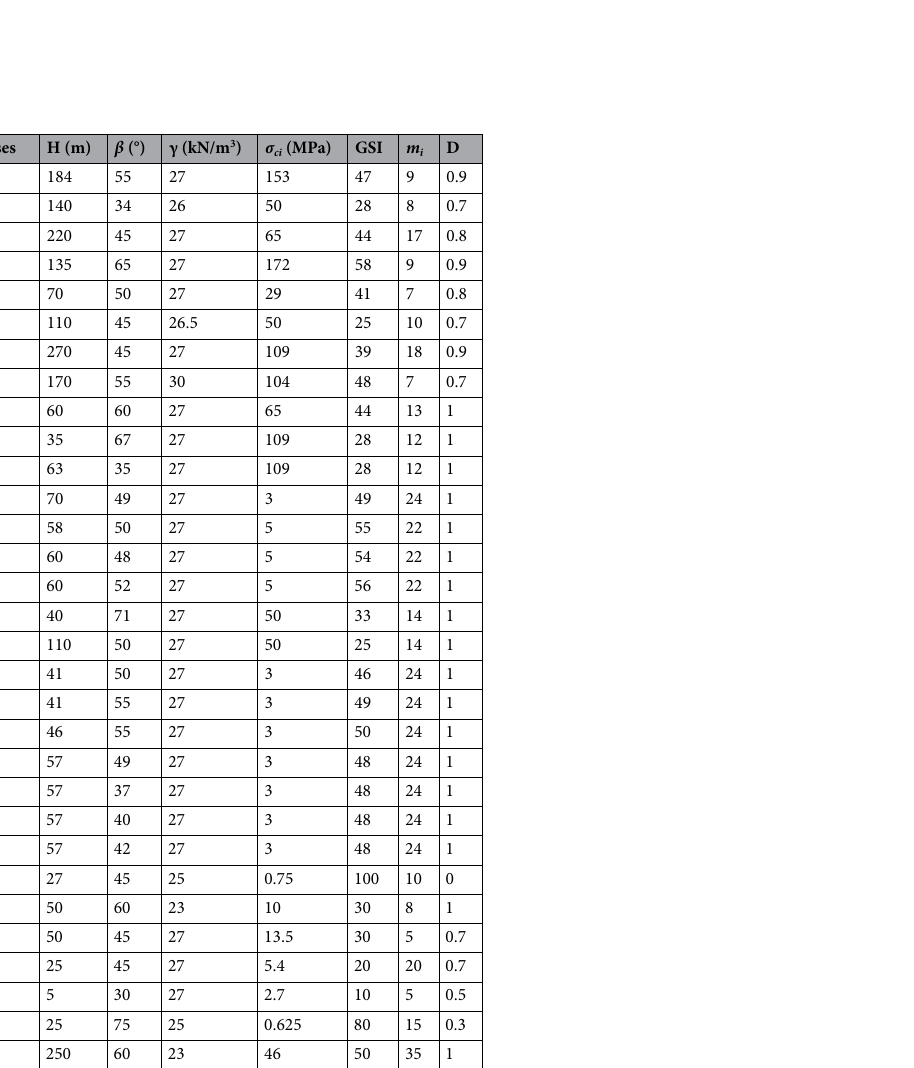
Table 3. various real cases of rock slopes 22